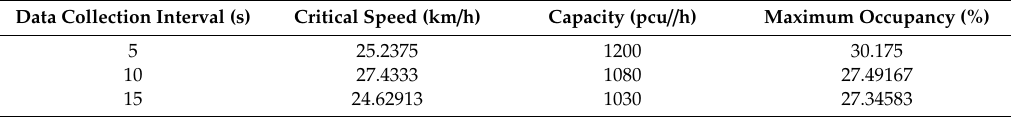
Table 3. Critical value in normalization processing in different time intervals.